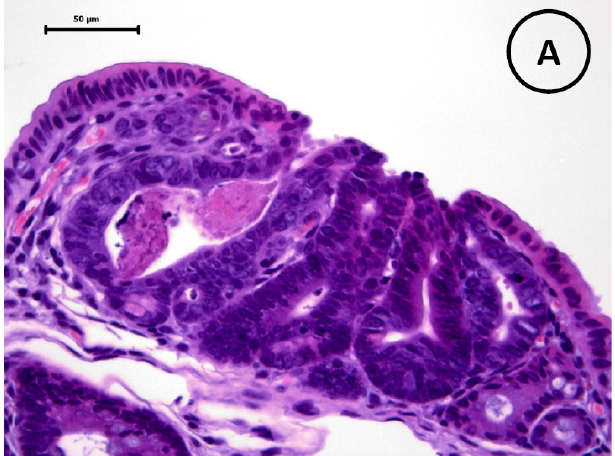
Figure 2. Histopathology of a colonic tumor developed in db/db-Min/+ mice. The tumor is histopathologically diagnosed as a tubular adenoma. Immunohistochemistry of β -catenin and IGF-1R in the tumor shows positive reaction of β -catenin in their cell membrane and cytoplasm and IGF-1R in their cytoplasm. Bars = 50 µm. ( A ) H & E stain; ( B ) β